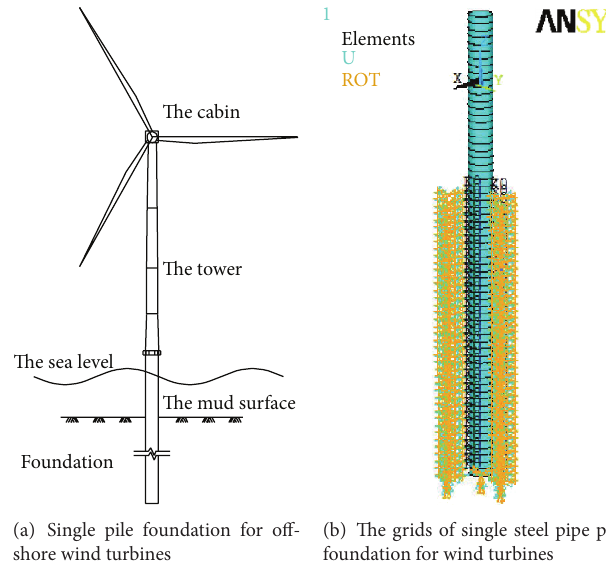
Figure 2: Finite element model of single steel pipe pile foundation for wind turbines.